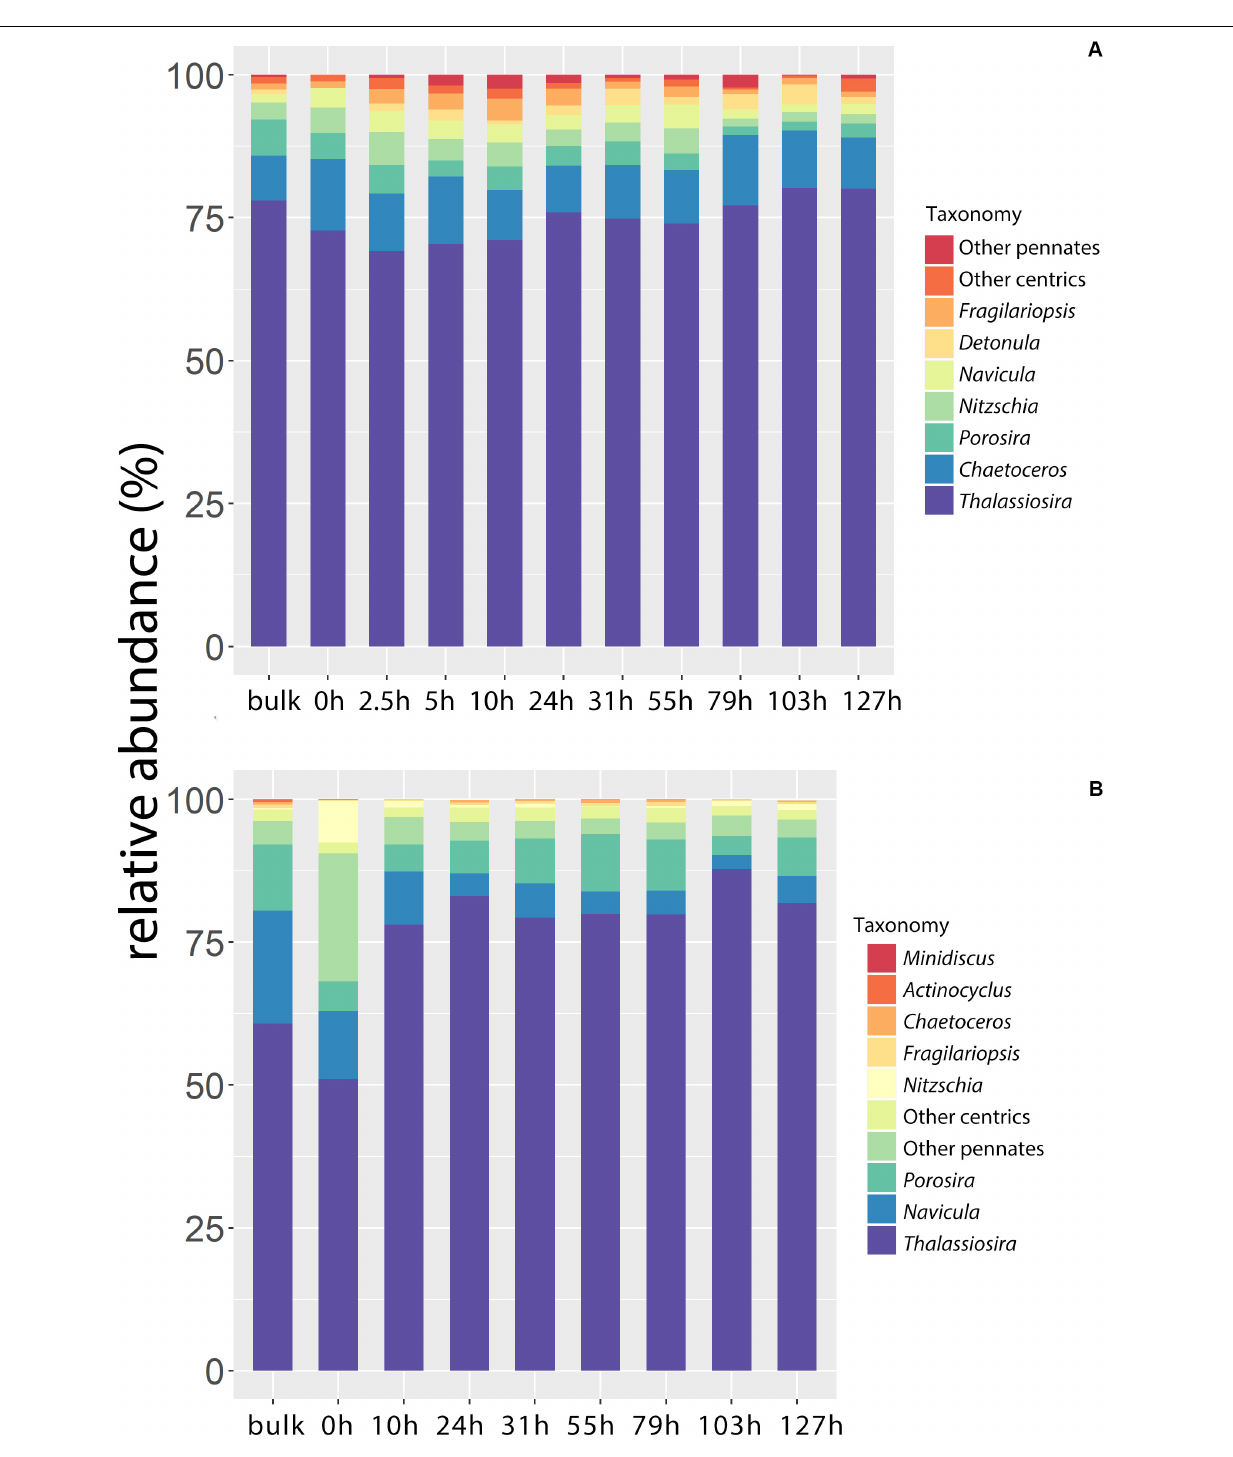
Frontiers in Marine Science |